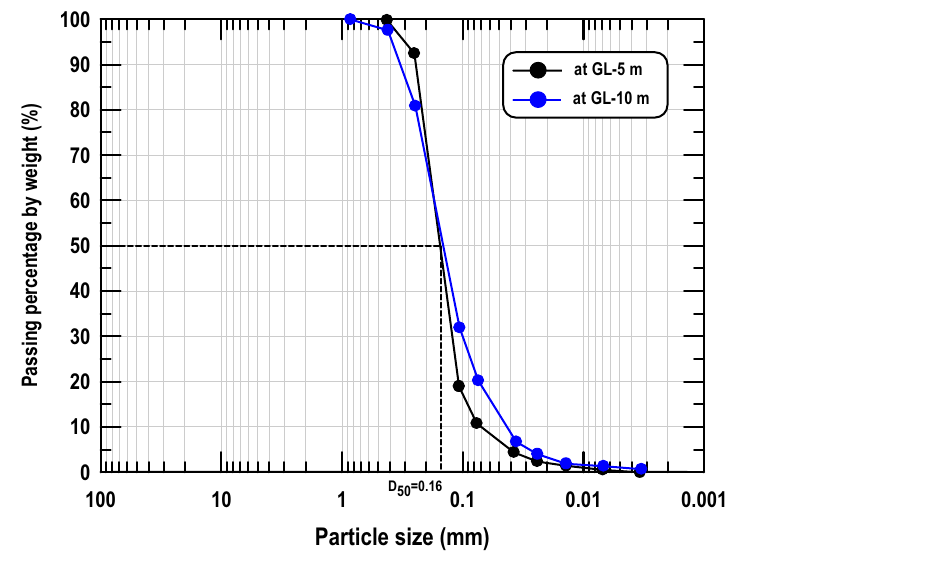
Figure 4. Typical particle size distribution in the RIC trial test